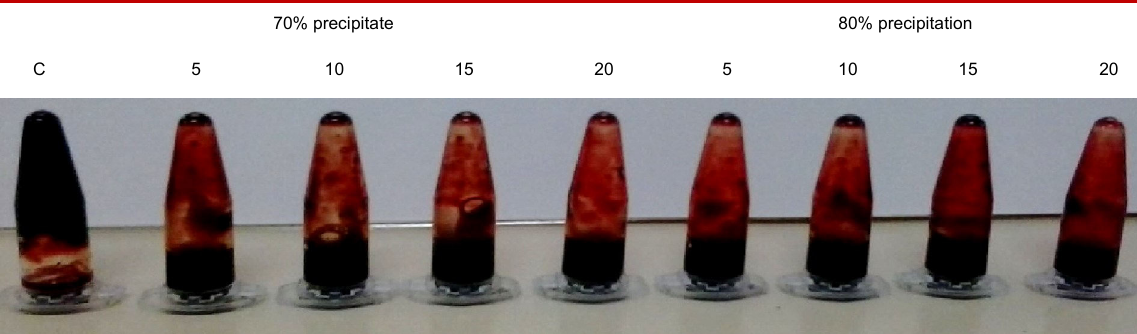
Figure 7: Holmstorm Method for Bacillus sp SFN mutated (5 min) precipitates in production media with shrimp shell (1 to 10 µL)